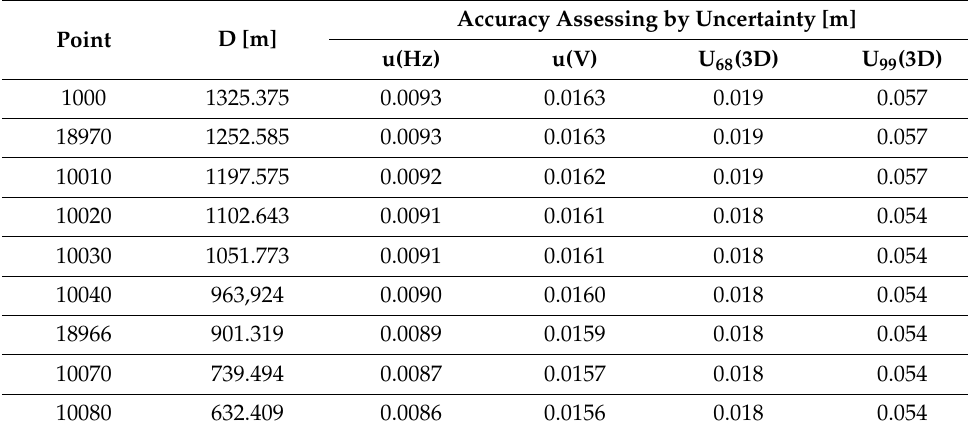
Table 6. Expected accuracy of real-time GNSS